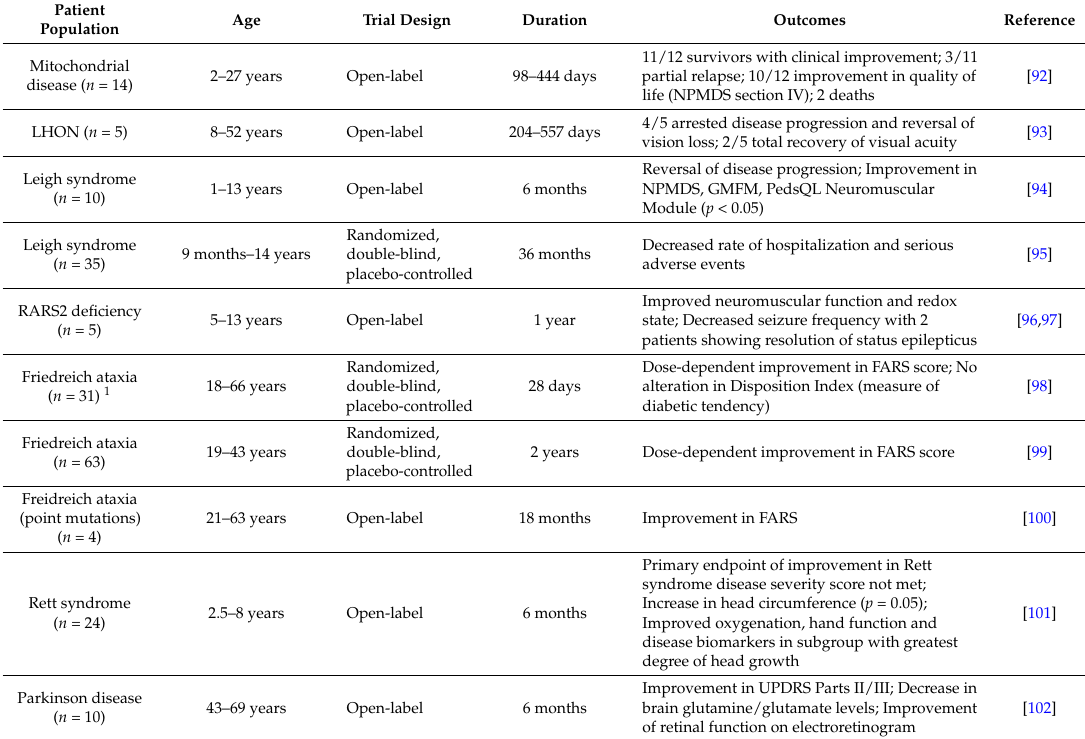
Table 2. EPI-743 clinical